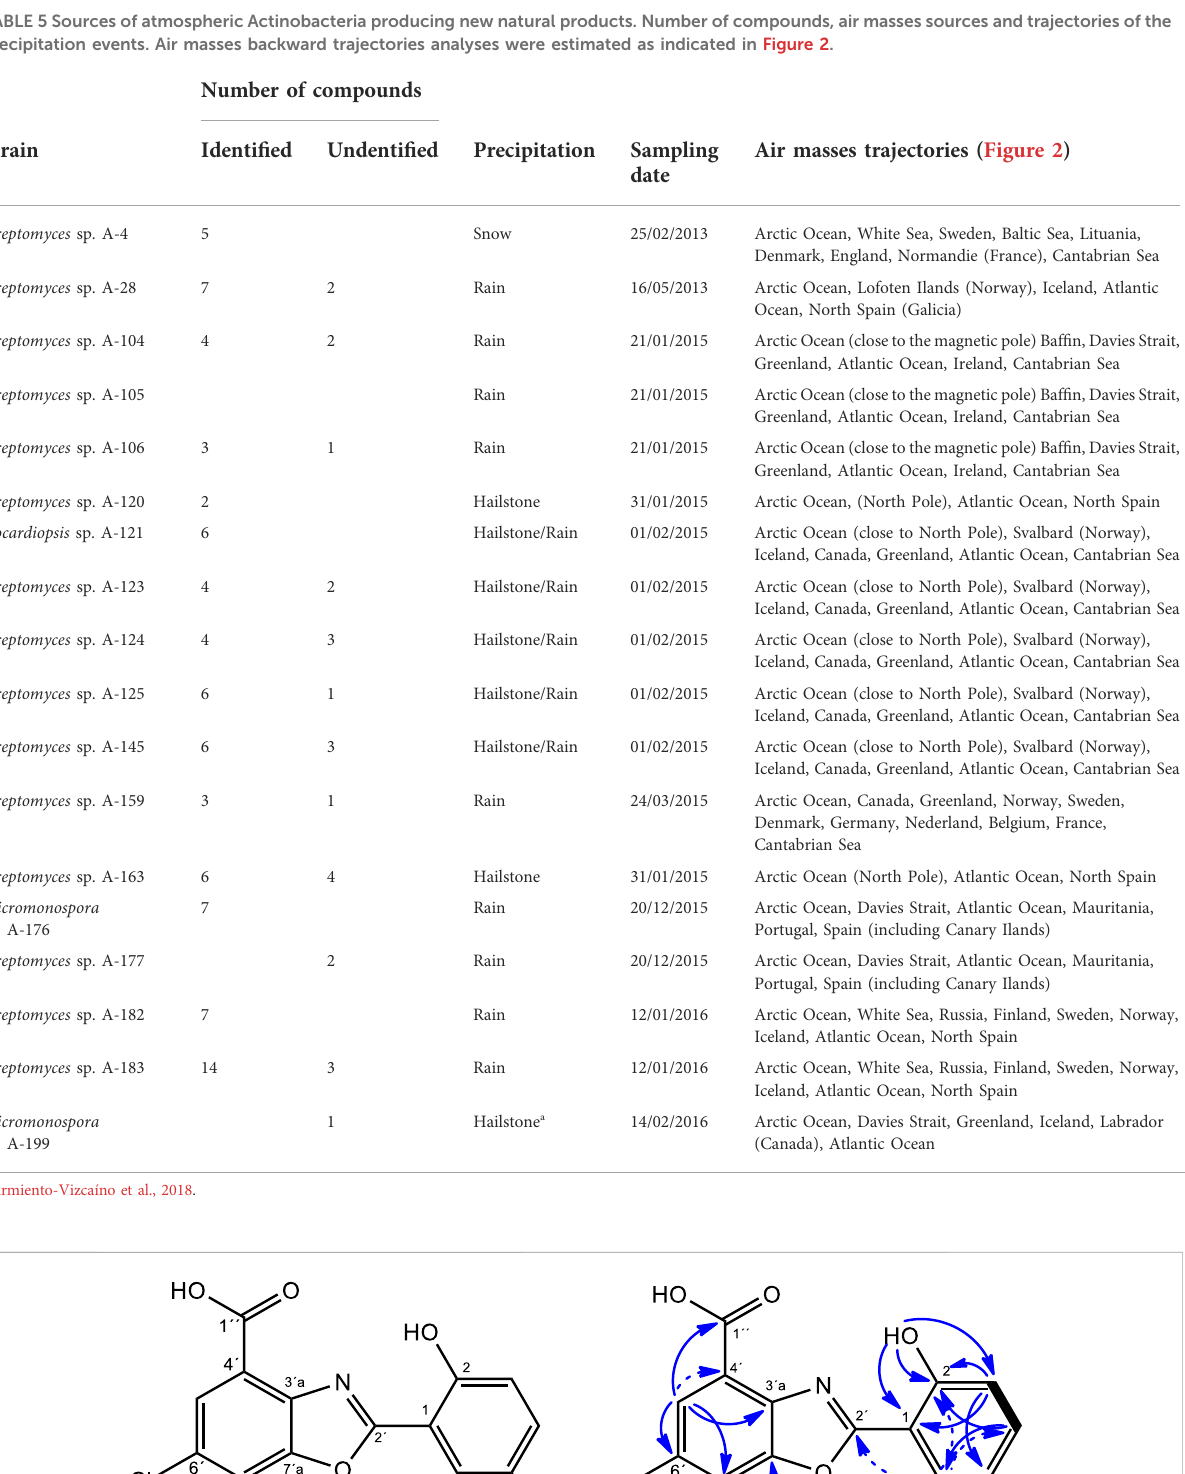
TABLE 5 Sources of atmospheric Actinobacteria producing new natural products. Number of compounds, air masses sources and trajectories of the precipitation events. Air masses backward trajectories analyses were estimated as indicated in Figure 2.